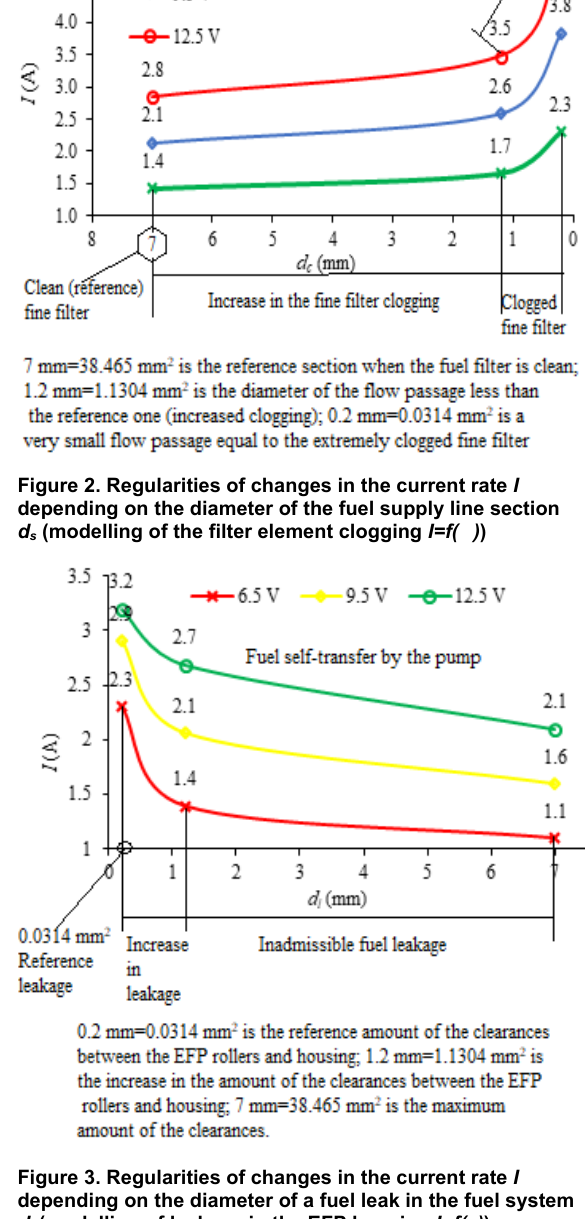
Figure 3. Regularities of changes in the current rate I depending on the diameter of a fuel leak in the fuel system d l (modelling of leakage in the EFP housing I=f(y)